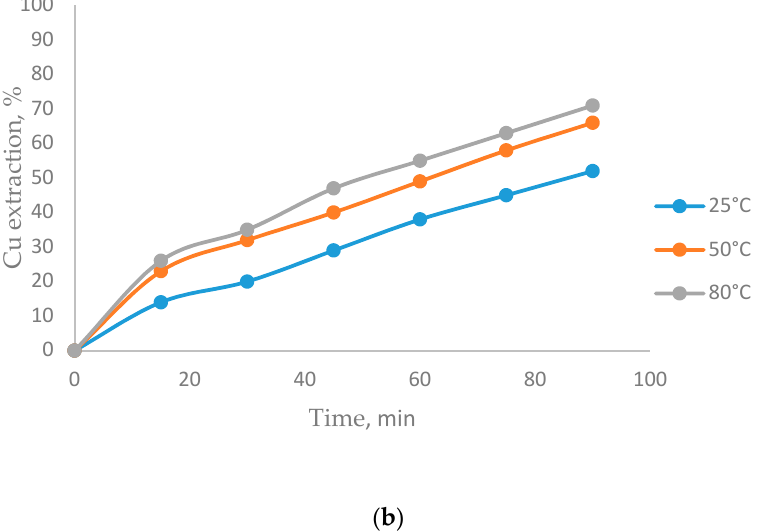
Figure 3. Effect of the temperature on the dissolution of Cu from chalcopyrite at different ratios of MnO 2 /CuFeS 2 (particle size of − 47 + 38 µm, ratio MnO 2 /CuFeS 2 of 2/1 ( a ) and 5/1 ( b ), H 2 SO 4 concentration to 1 mol/L and 39.19 g/L of chloride).